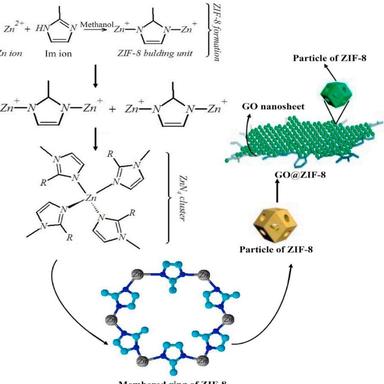
Schematic illustration of ZIF-8 and GO@ZIF-8 synthesis .